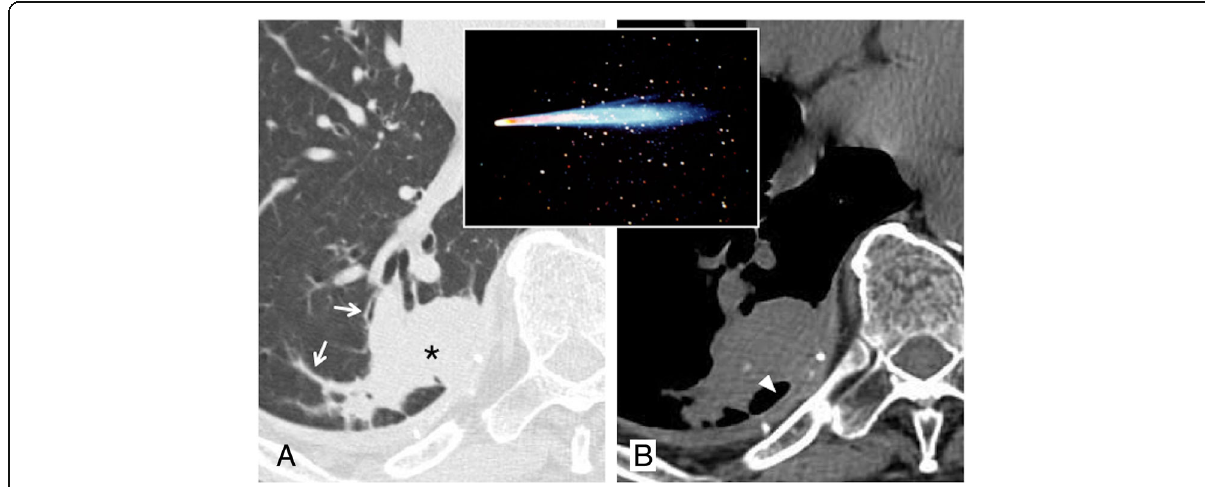
Fig. 7 Comet tail sign. Axial CT image ( a ) shows a round consolidation (black asterisk) and stretched vessel and bronchus (white arrows): these combinations — reproducing a “ comet tail ” at the border of a round lesion — suggest the presence of round atelectasis. On axial CT image ( b , mediastinal window), a dorsal pleural plaque with calcification is also appreciable (white